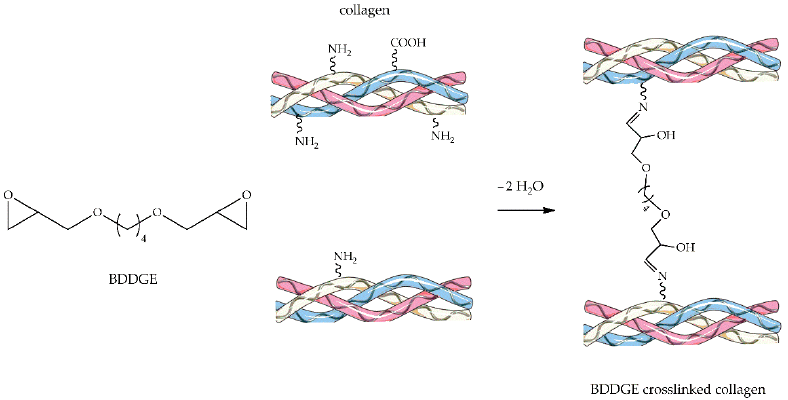
Figure 6. Schematic representation of BDDGE-crosslinking reaction.